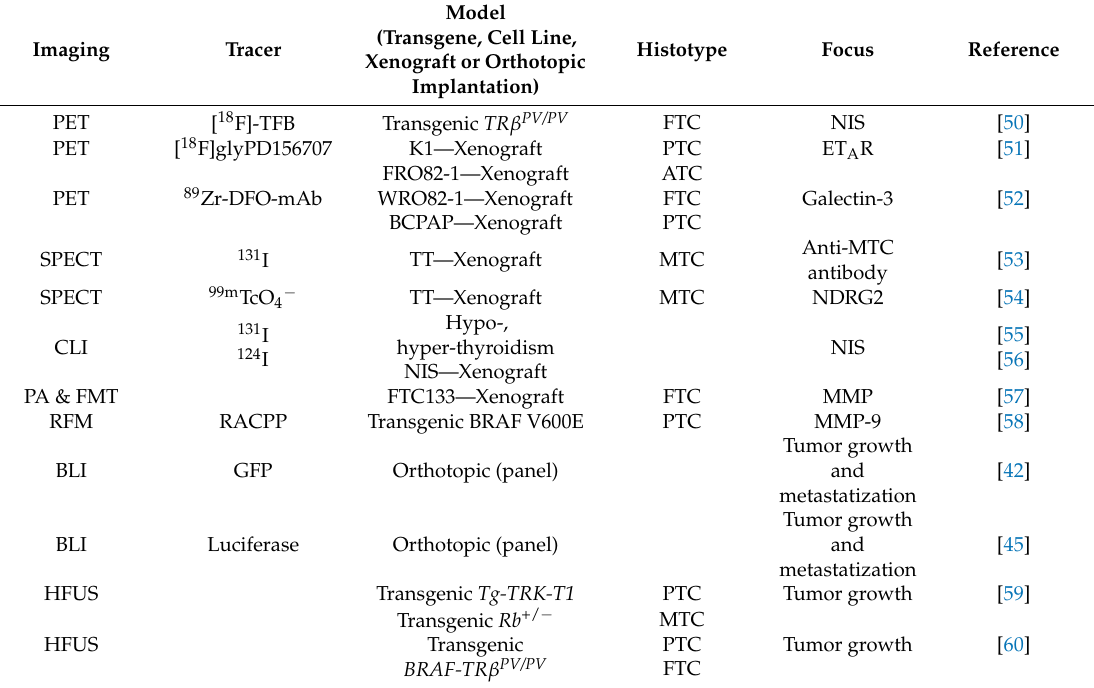
Table 1. Preclinical imaging techniques applied in mouse models of thyroid